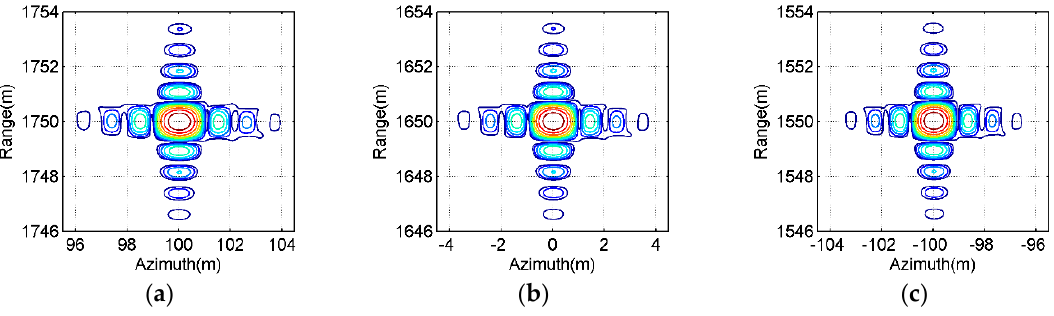
Figure 9. Contours of the imaging results obtained by the bistctic DTDA for all selected point-like scatterers in Figure 8a. ( a ) Scatterer C; ( b ) Scatterer E; ( c ) Scatterer G.